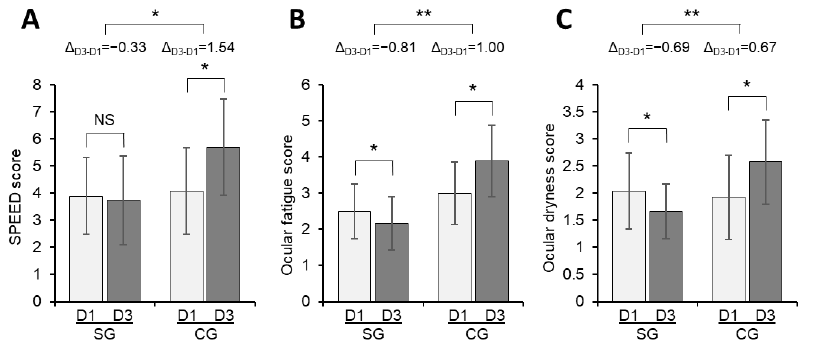
Figure 1. Change in the SPEED score ( A ), ocular fatigue score ( B ), and ocular dryness score ( C ) from D1 to D3 for the SG and CG. The bars represent means, and the error bars the 95% confidence interval. Statistical significance: *, p < 0.05; **, p < 0.001. CG, control group; D1, Day 1; D3, Day 3; ∆D1 − D3, difference between Day 1 and Day 3; NS, not significant; SG, study group.